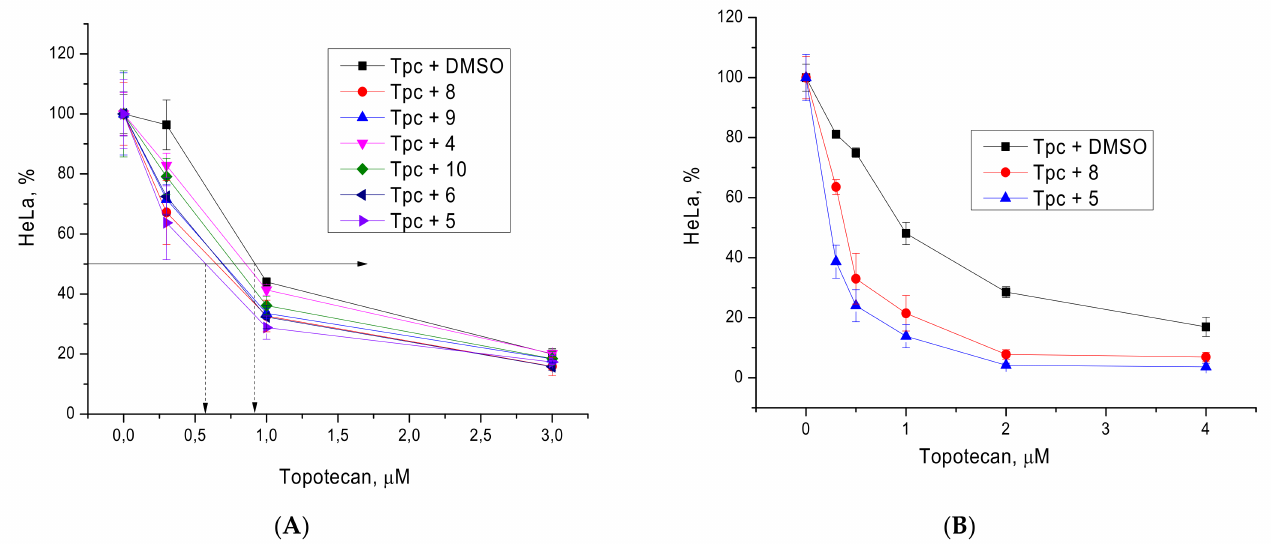
Figure 3. ( A ) The influence of derivatives 4 – 6 and 8 – 10 (5 µ M) on topotecan cytotoxicity against HeLa cells. The error bars show standard deviations. Dotted lines show an increase in the cytotoxicity of topotecan in the presence of the ligands. ( B ) The influence of compounds 5 and 8 at 10 µ M on topotecan